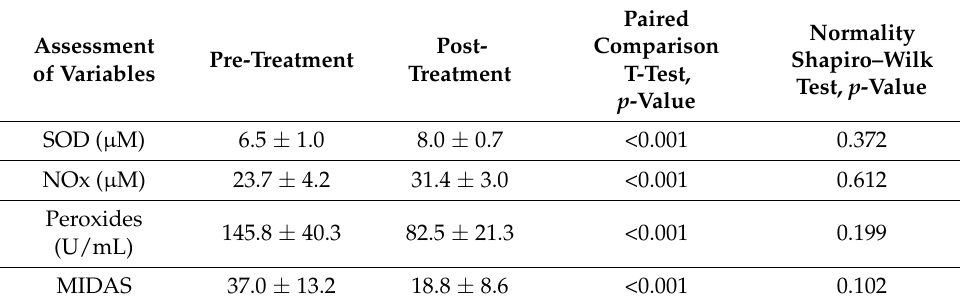
Table 1. Means ± standard deviations of the parameters assessed pre- and post-treatment for the group of participants, with the p -values of the paired comparison and normality check.